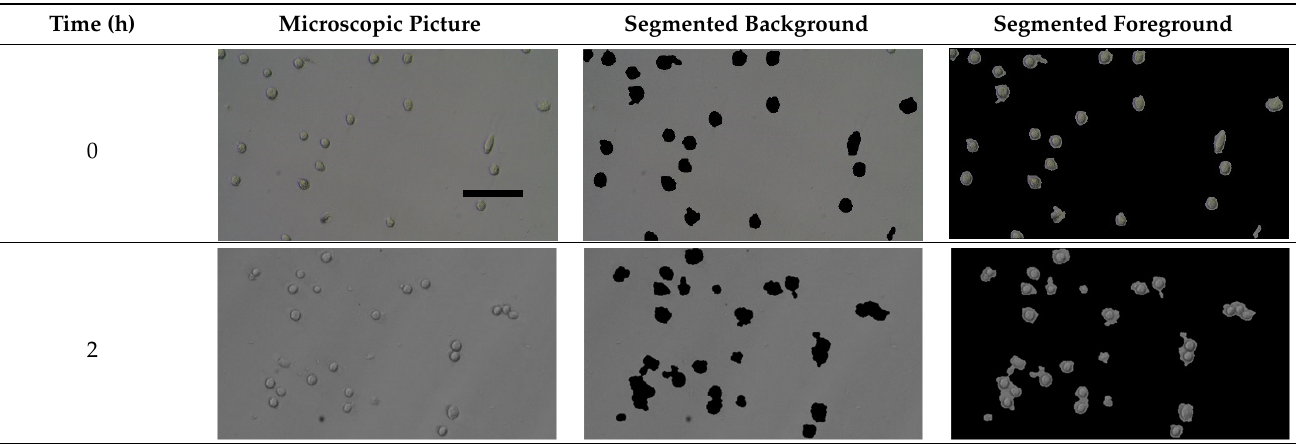
Table 2. Image processing procedures of cell detection: microscopic (left), segmented background (middle), and segmented foreground (right) images. The scale bar in the images is 0.1 mm, and the microscope magnification was 10 × .